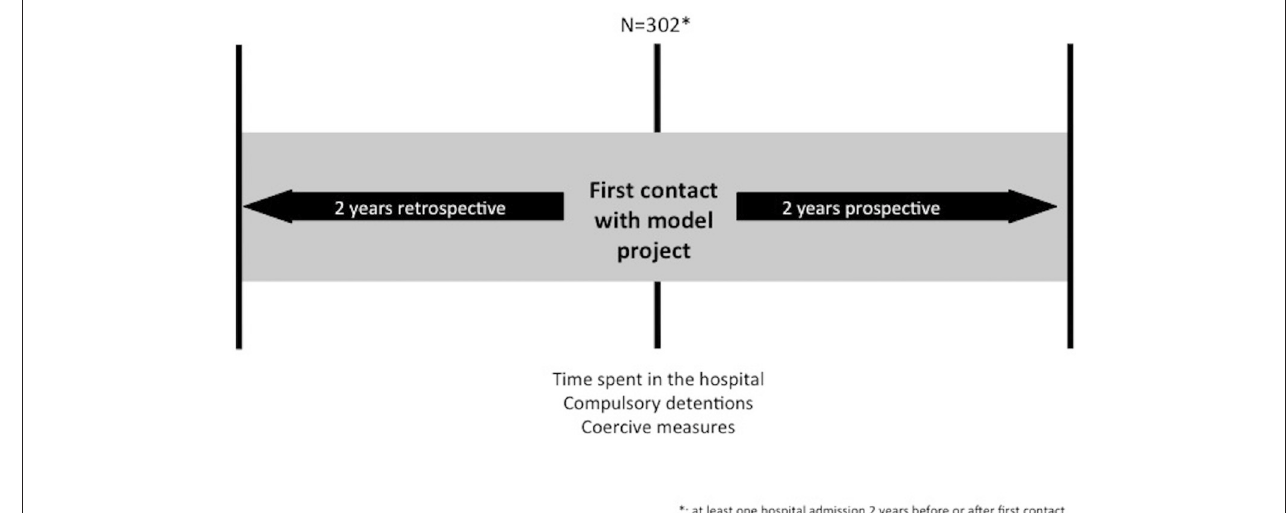
FIGURE 2 | Study design.